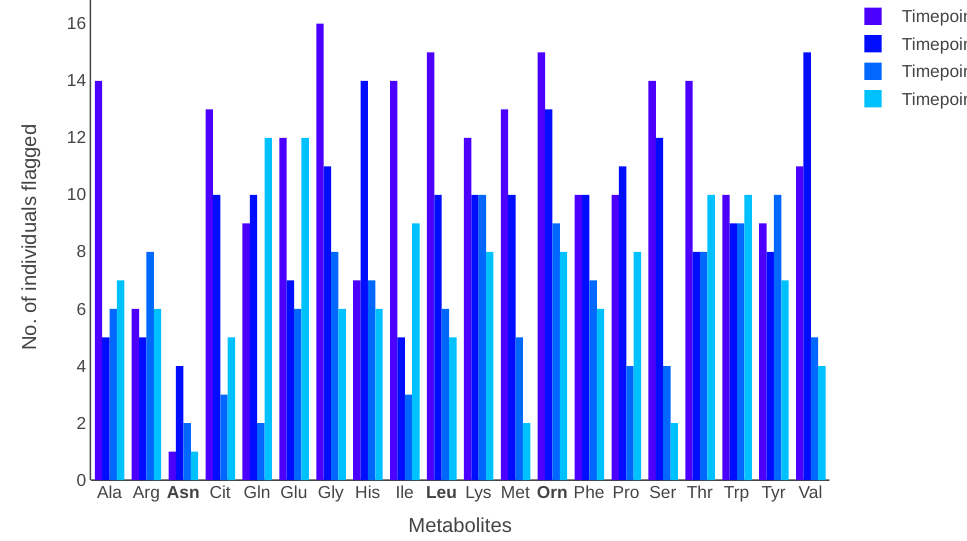
Figure 3. The number of individuals flagged for each metabolite. For each metabolite, a bar indicates a different time point. Bold font indicates metabolites with the highest or lowest number of individuals flagged across the four time